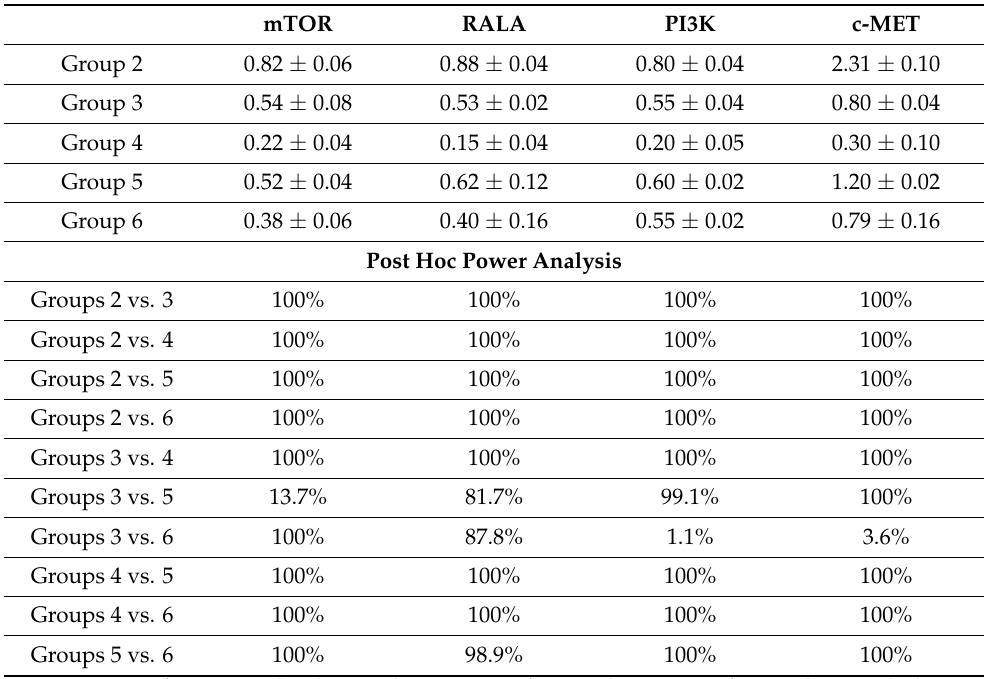
Table 2. Statistical analysis of genes expression of (mTOR, RALA, PI3K and c-MET) in control and treatment with Q, Ru III /Q, and DG of HepG2 cells using qRT-PCR. mTOR RALA PI3K